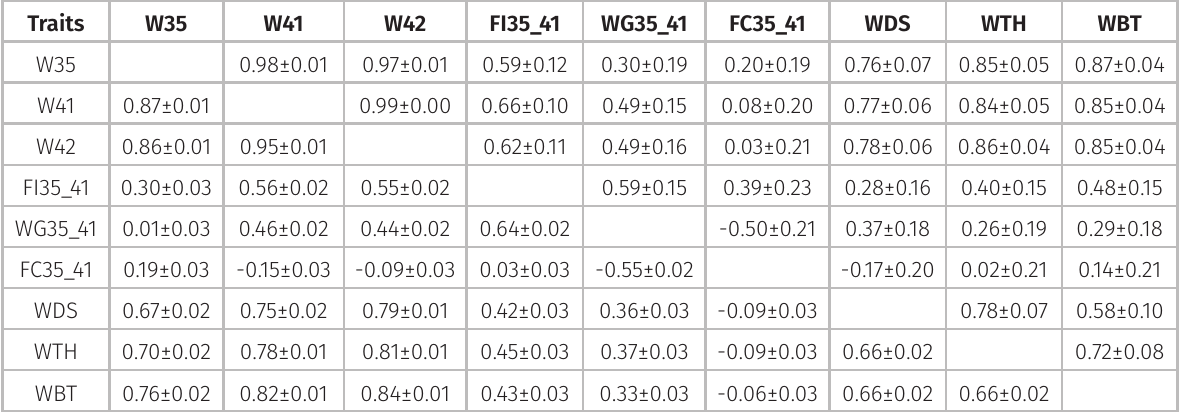
Table III. Genetic (above diagonal) and phenotypic (below diagonal) correlations and respective standard errors among performance and carcass traits.